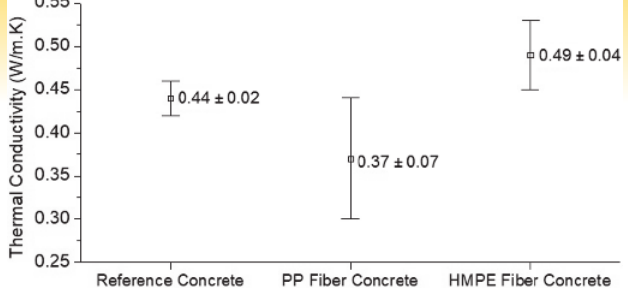
Figure 3 Thermal conductivity coefficient to the reference concrete and concrete reinforced with fibers